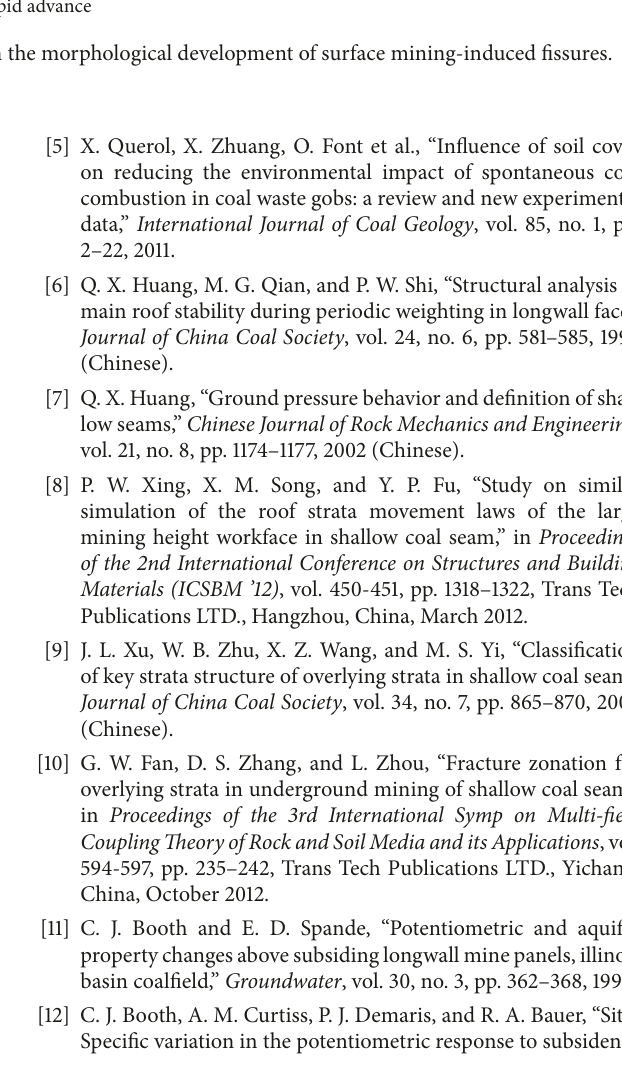
Figure 16: The influence of mining coal face advancing speed on the morphological development of surface mining-induced fissures.